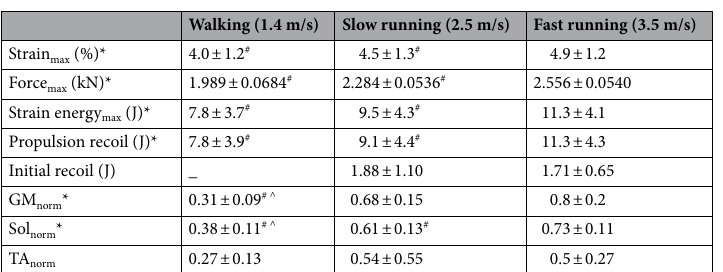
Figure 4. Achilles tendon (AT) strain, force and strain energy as well as EMG activity of the gastrocnemius medialis (GM), soleus (Sol) and tibialis anterior (TA) muscle during walking (1.4 m/s), slow running (2.5 m/s), and fast running (3.5 m/s). The gray highlighted area around the curves indicates the standard error. The x-axis is normalized to the gait cycle. The gray dashed vertical line separates the contact and swing phase (average of eleven participants with ten gait cycles).